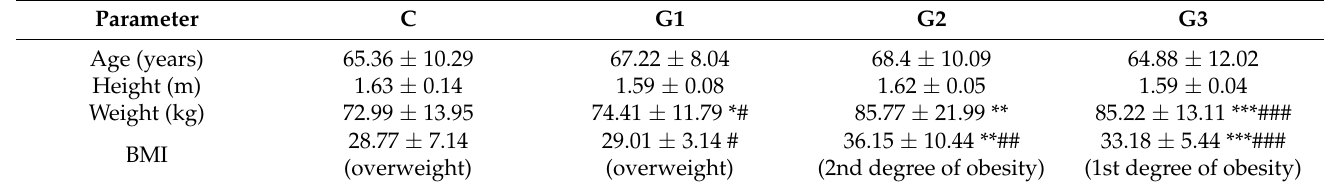
Table 2. Characteristics of patients enrolled in the